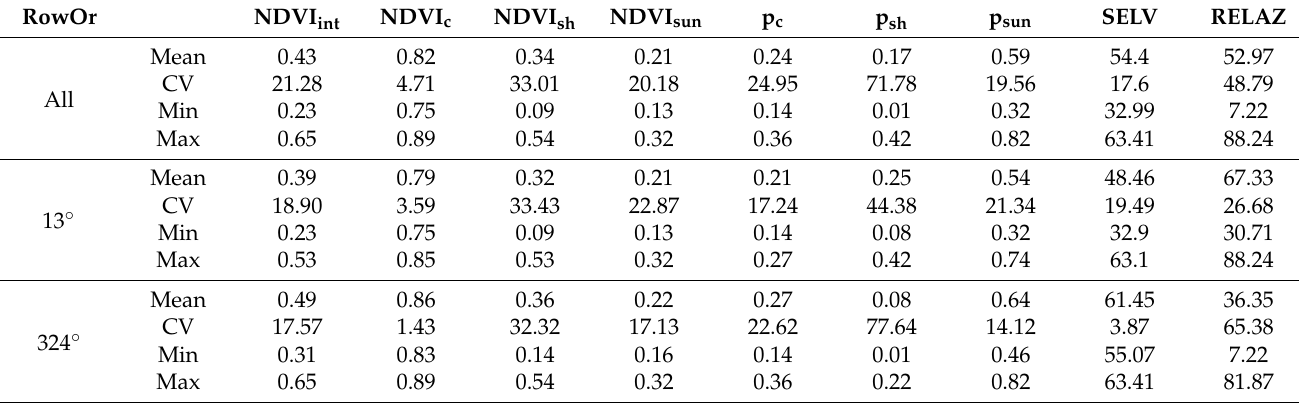
Table 1. Summary statistics of the fraction elements (variables) in expression (1) and driving factors sun elevation and relative azimuth.